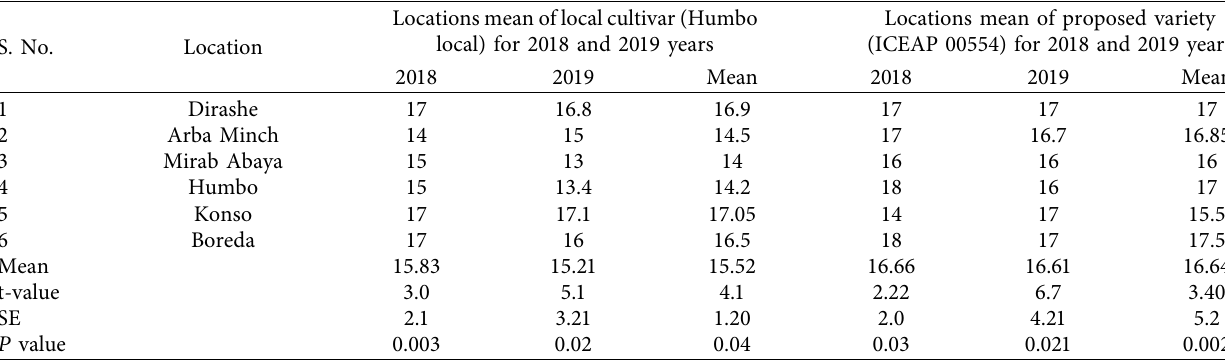
Mean t-value SEM, mean standard error. Table 4: Hundred seed weight (gm) of pigeon pea genotypes across locations during the 2018 and 2019 cropping seasons, South Ethiopia. S. No.